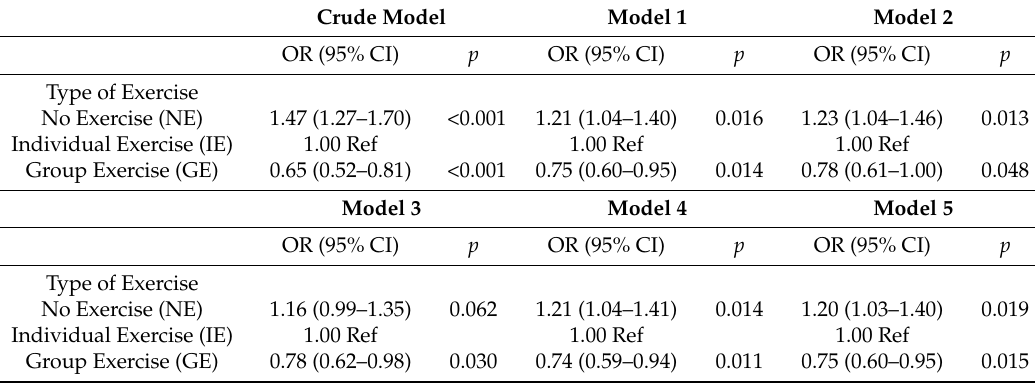
Table 3. Multivariate adjusted odds ratios and 95% confidence intervals for falls by type of